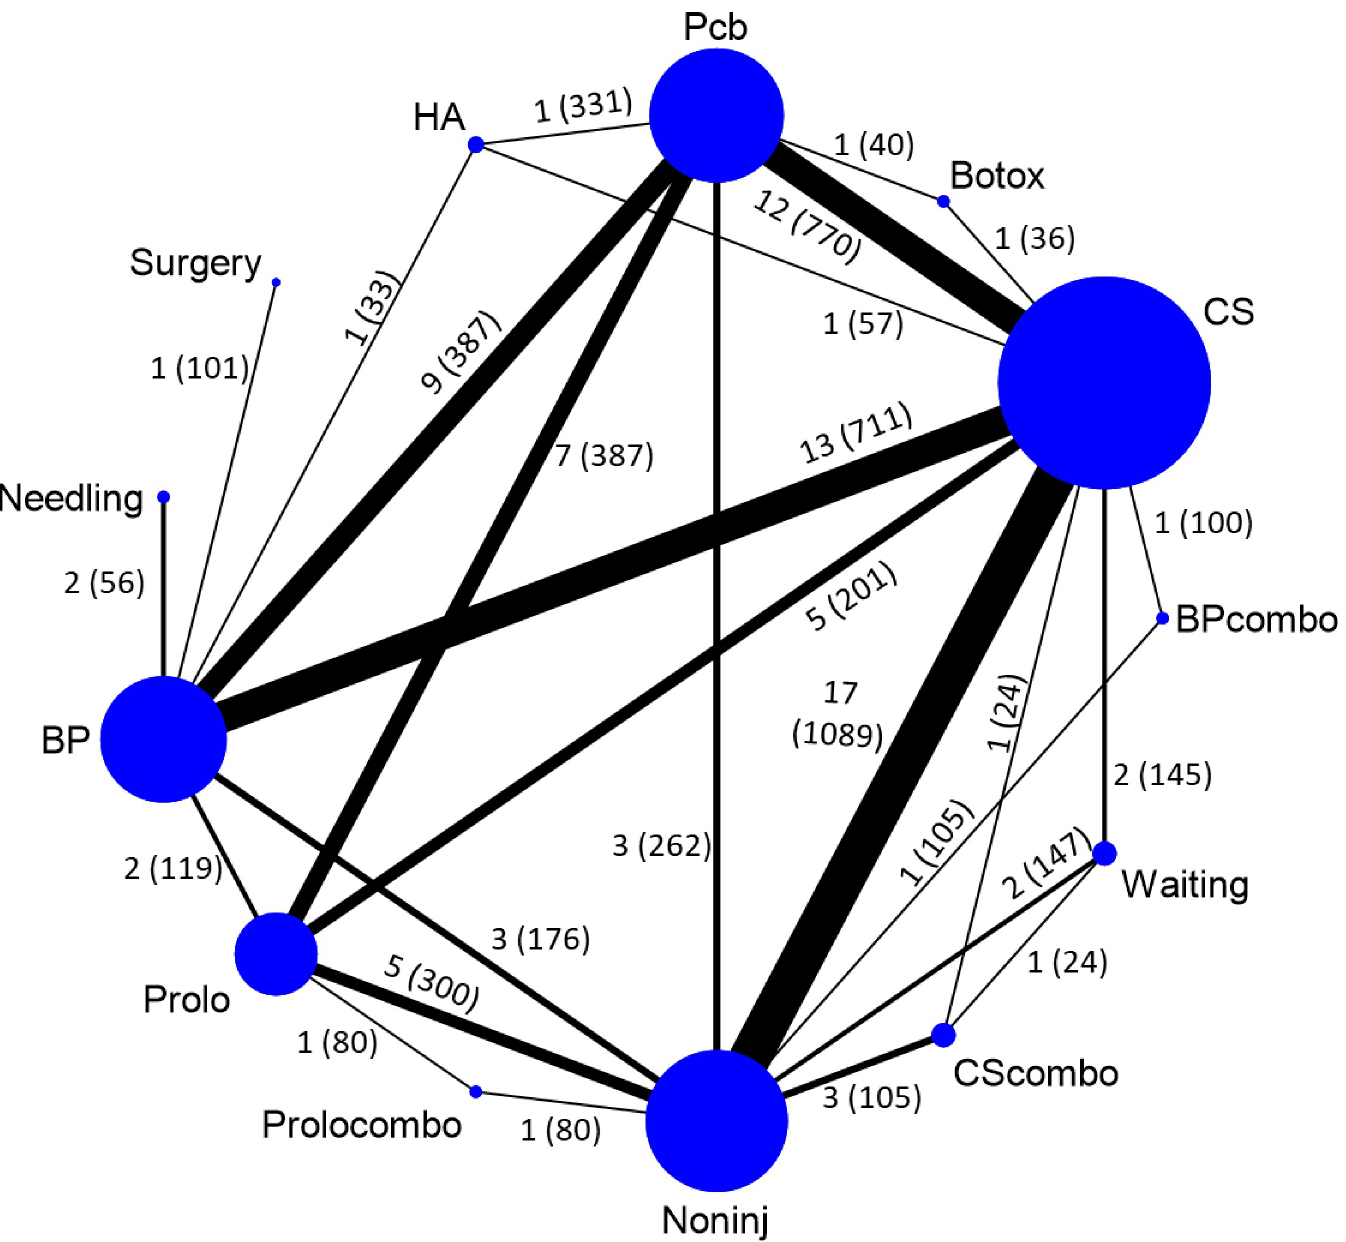
Fig 2. Network geometry. Note: BP = blood product; BPcombo = blood product combination therapy; Botox = botulinum toxin; CS = corticosteroid; CScombo = corticosteroid combination therapy; HA = hyaluronic acid; Noninj = non-injections; Pcb = placebo; Prolo = prolotherapy; Prolocombo = prolotherapy combination therapy. The size of the node corresponds to the number of participants assigned to the intervention while thickness of the connecting line corresponds to the number of the studies included.